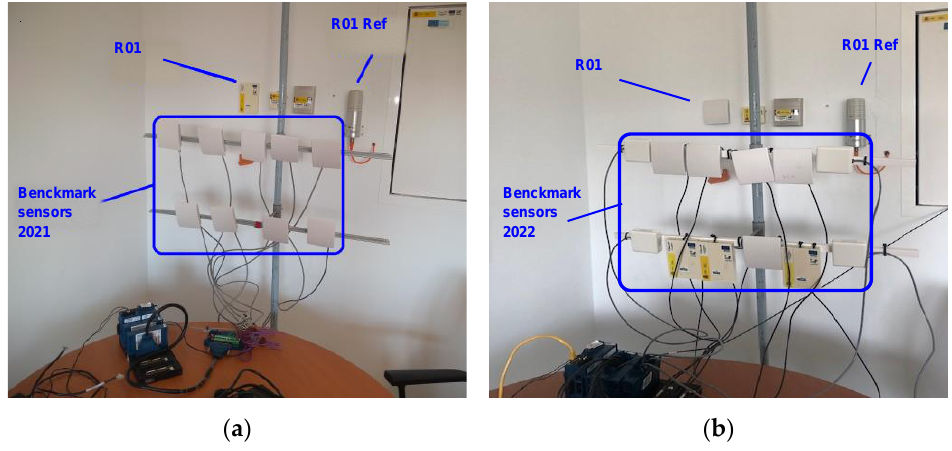
Figure 2. ( a ) Benchmark set-up 2021. ( b ) Benchmark set-up 2022.